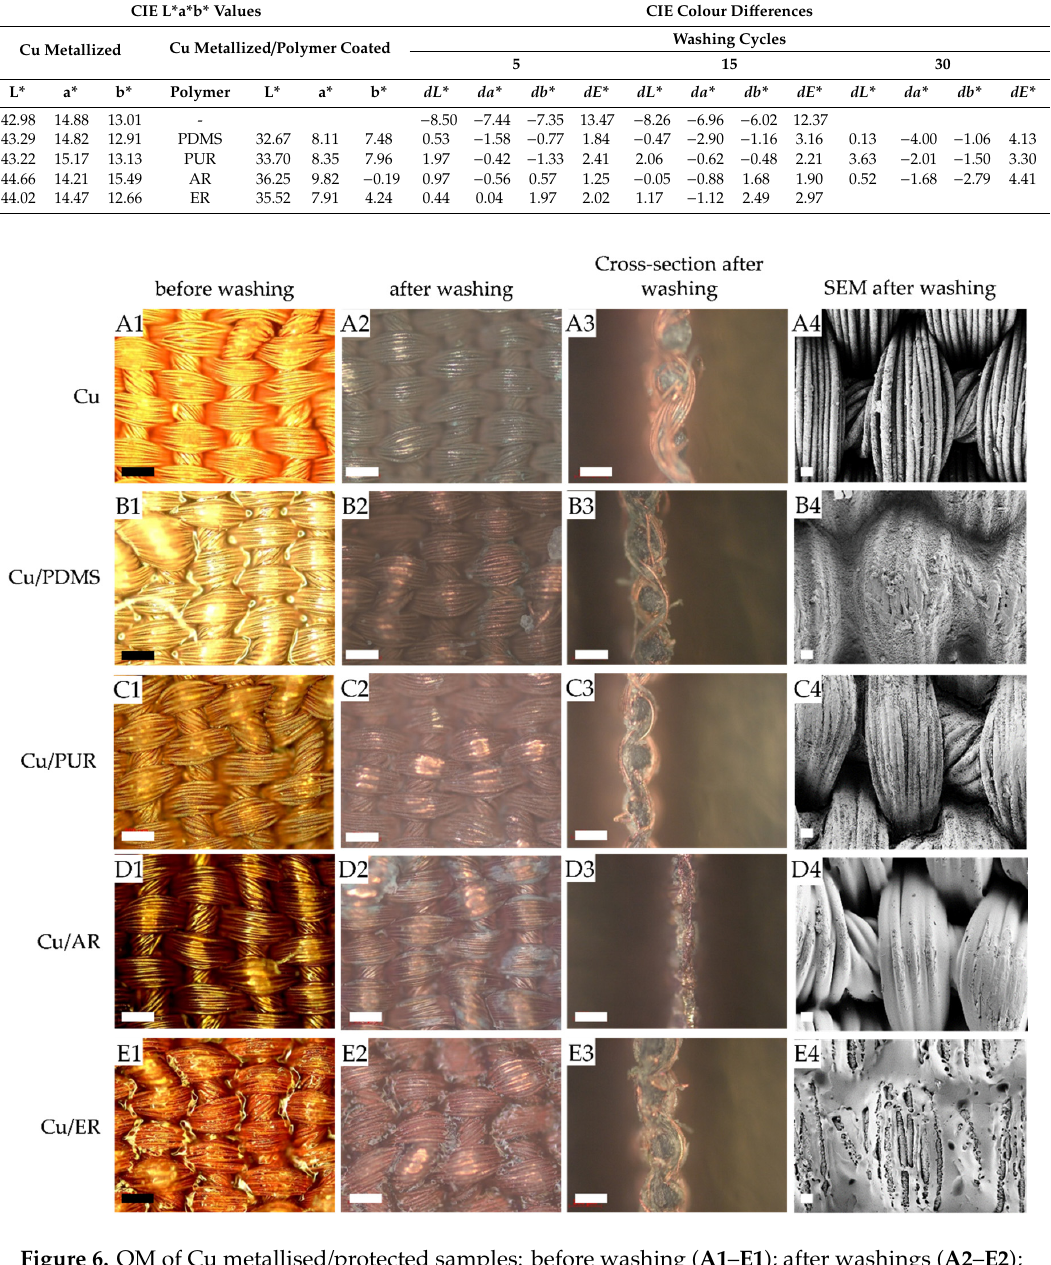
Figure 6. OM of Cu metallised / protected samples: before washing ( A1 – E1 ); after washings ( A2 – E2 ); cross-section after washings ( A3 – E3 ); and SEM after washings ( A4 – E4 ); Cu ( A1 – A4 ); Cu / PDMS ( B1 – B4 ); Cu / PUR ( C1 – C4 ); Cu / AR ( D1 – D4 ); Cu / ER ( E1 – E4 ). Scale bar: 200 µ m for OM and 20 µ m for SEM.